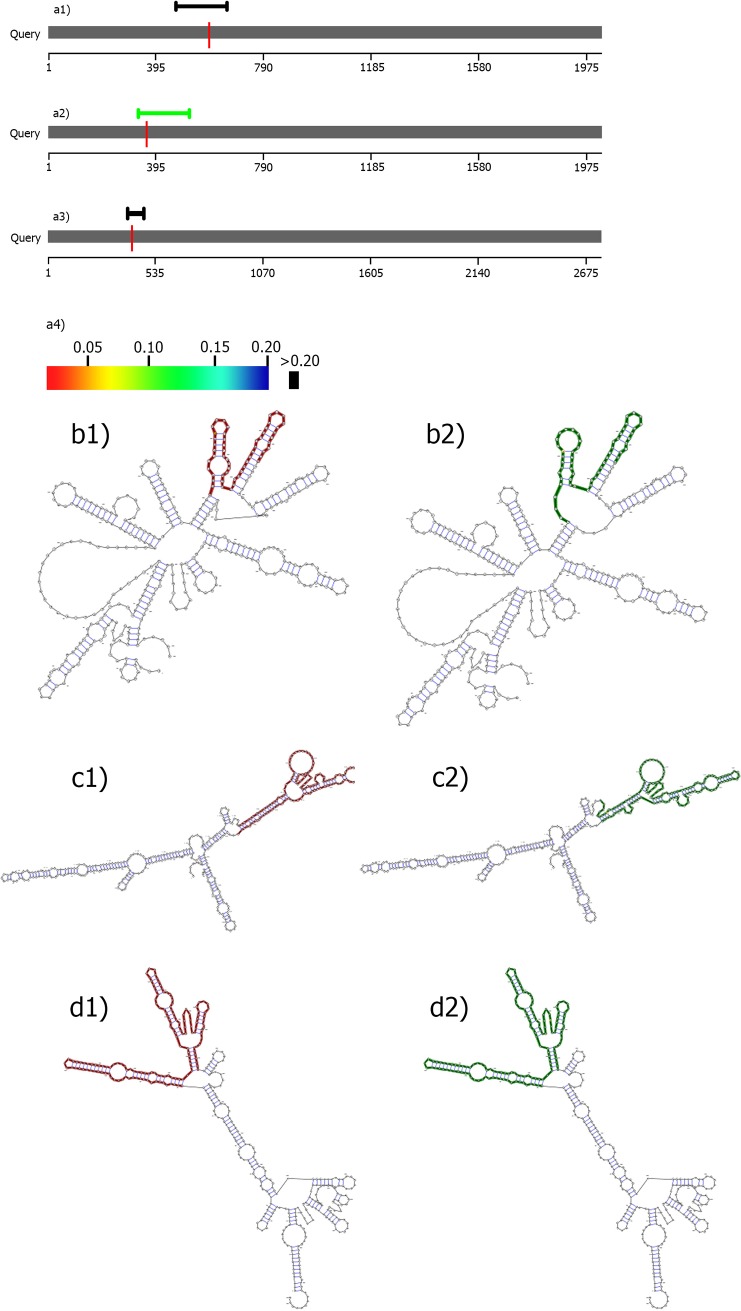
RNAsnp analysis of rs2287499, rs1042522 and rs2287498 SNPs.Local regions for a1) R72P substitution in TP53, a2) R68G substitution in WRAP53, a3) F150F substitution in WRAP53. a4) black lines demonstrate insignificant alteration (P >0.02) and other colors are demonstration of significant changes. Secondary RNA structure of R72P substitution in b1) mutation and b2) wild-type. Secondary RNA structure of R68G substitution in c1) mutation and c2) wild-type. Secondary RNA structure of F150F substitution in d1) mutation and d2) wild-type.